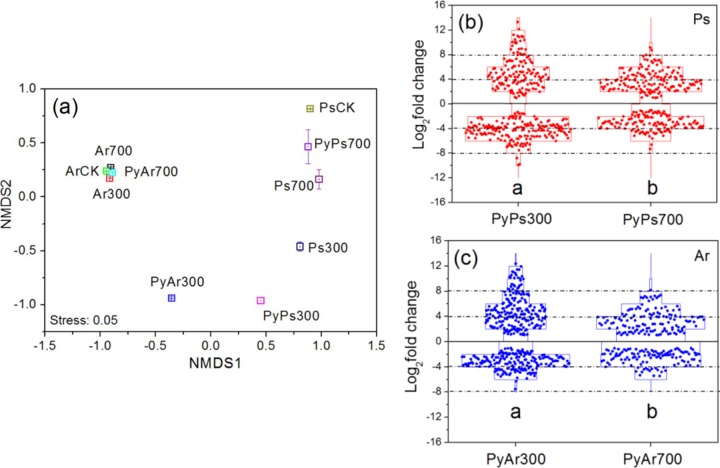
(a) Nonmetric multidimensional scaling plots (NMDS) of bacterial community patterns in the PyOMs, control soils, and PyOM-amended soils based on Bray-Curtis metric using OTU abundances. (b and c) Log2-fold change of differential abundant OTUs in PyOMs extracted from Ps soil and Ar soil, respectively. Ps300, Ps soil amended with PyOM300; Ps700, Ps soil amended with PyOM700; Ar300, Ar soil amended with PyOM300; Ar700, Ar soil amended with PyOM700. PyOM-amended soils in this figure can to some extent show the effect of the transition between PyOM particles and control soils. Other abbreviations are described in the main text. PERMANOVA showed the statistical significance of differences between treatments in community composition as follows: for PyPs300 versus PsCK, P < 0.05; for PyPs700 versus PsCK, P > 0.05; for PyAr300 versus ArCK, P < 0.05; for PyAr700 versus ArCK, P > 0.05; for PyPs300 versus PyPs700, P < 0.05; for PyAr300 versus PyAr700, P < 0.05. Different lower letters represent significant differences (P < 0.05) in the Log2-fold change of OTUs in PyOM300 and PyOM700 by t test.